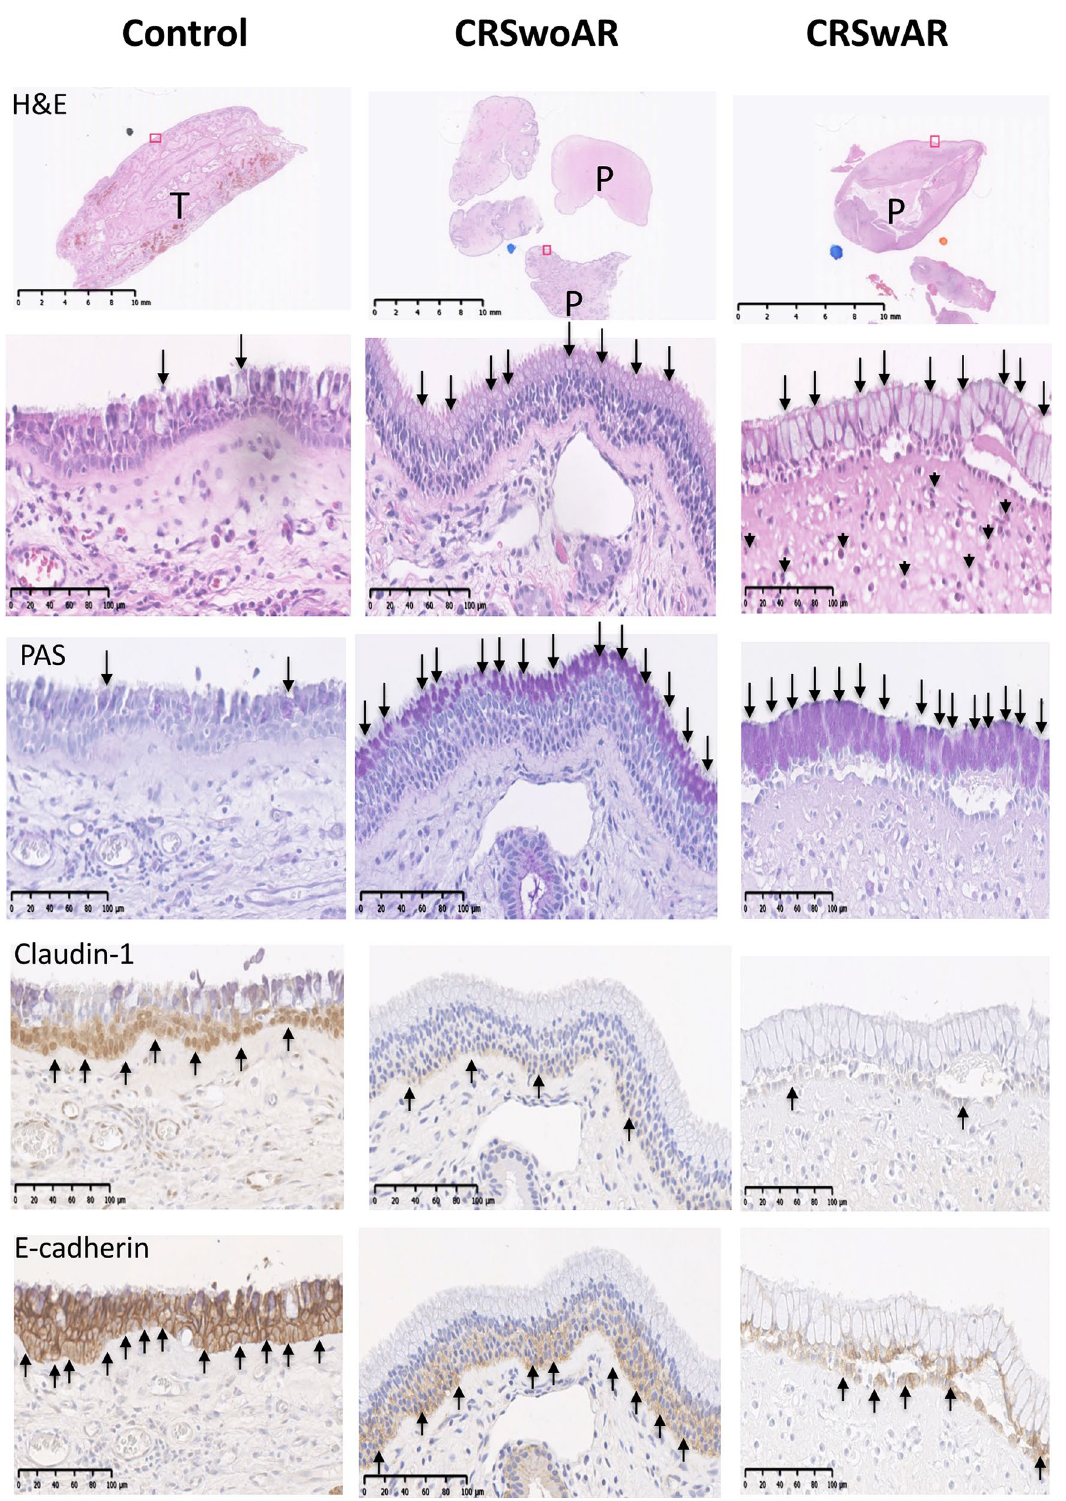
Figure 1. Representative images showing histological features of nasal tissues of various groups. Increased number of goblet cells, increased mucus production, decreased claudin-1 and e-cadherin staining are found in tissue sections of CRSwoAR and CRSwAR. Control: without rhinosinusitis; CRSwoAR: chronic rhinosinusitis without allergic rhinitis; CRSwAR: chronic rhinosinusitis with allergic rhinitis; T: inferior turbinate; P: nasal polyp; H&E: hematoxylin and eosin staining; PAS: periodic acid-Schiff staining. Arrow heads mark the eosinophils; arrows mark the representative goblet cells, PAS staining, e-cadherin and claudin-1 staining